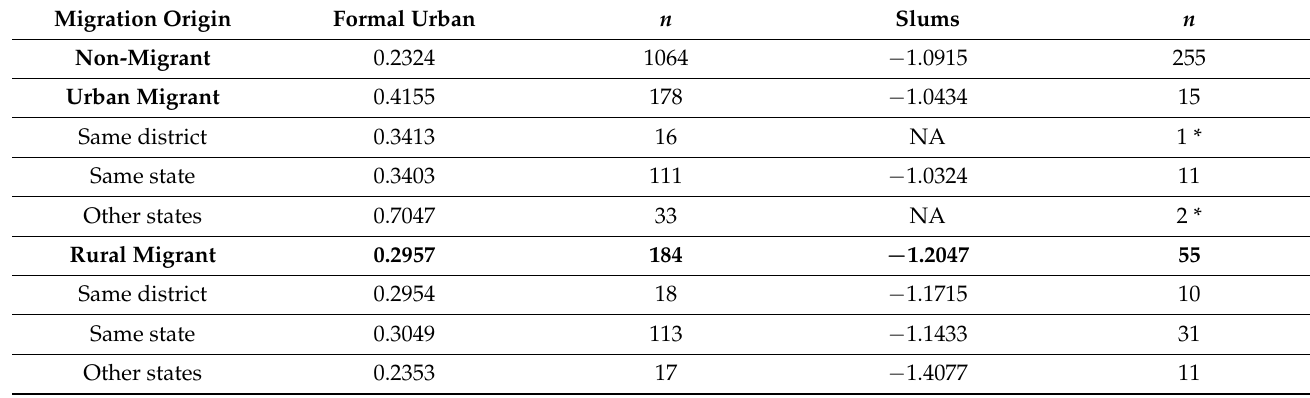
Figure 9. Resilience matrix displaying kernel density estimation of RCI of sub-groups based on the migration characteristic migration distance. Table 5. RCI sub-groups based on the migration characteristic migration distance (* low sample